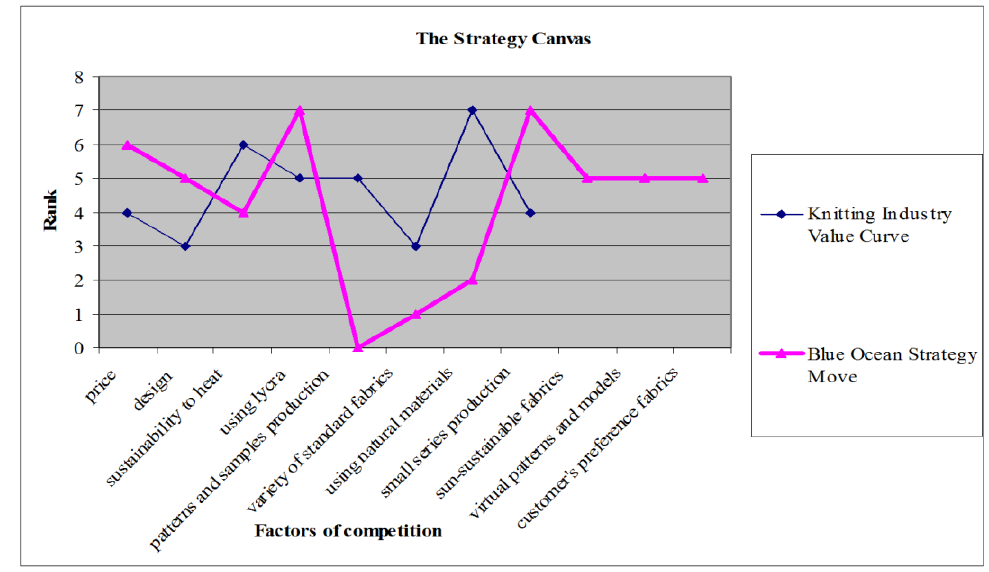
Fig. 3. A possible “Blue Ocean” strategy move for the studied